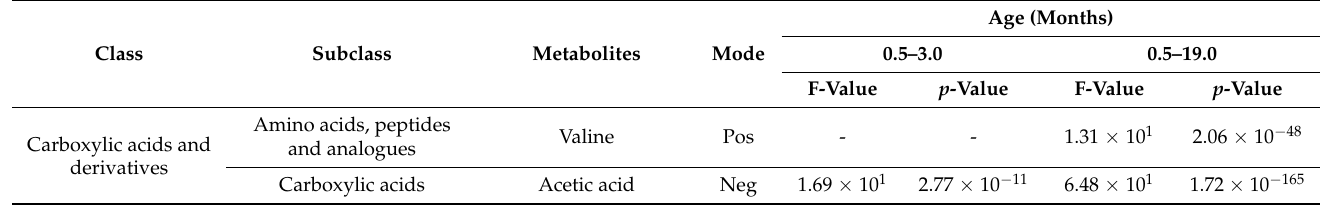
Table 1. Metabolites which change over time in HF heifers aged 0.5 to 3 months and 0.5 to 19 months of